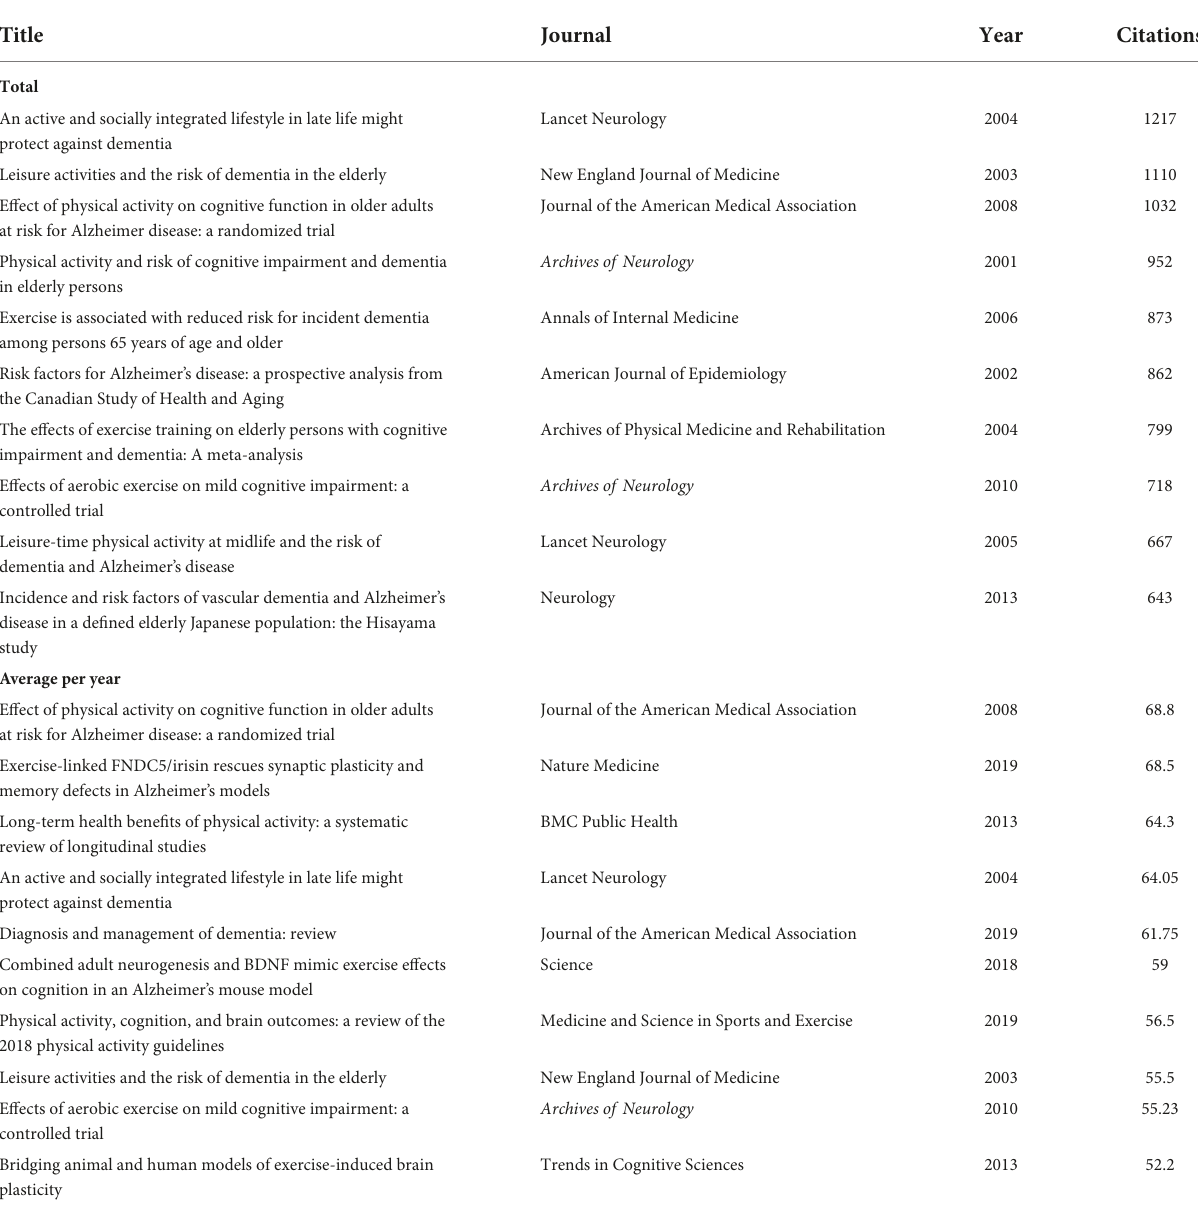
TABLE 5 The top 10 papers based on the number of citations on exercise and AD